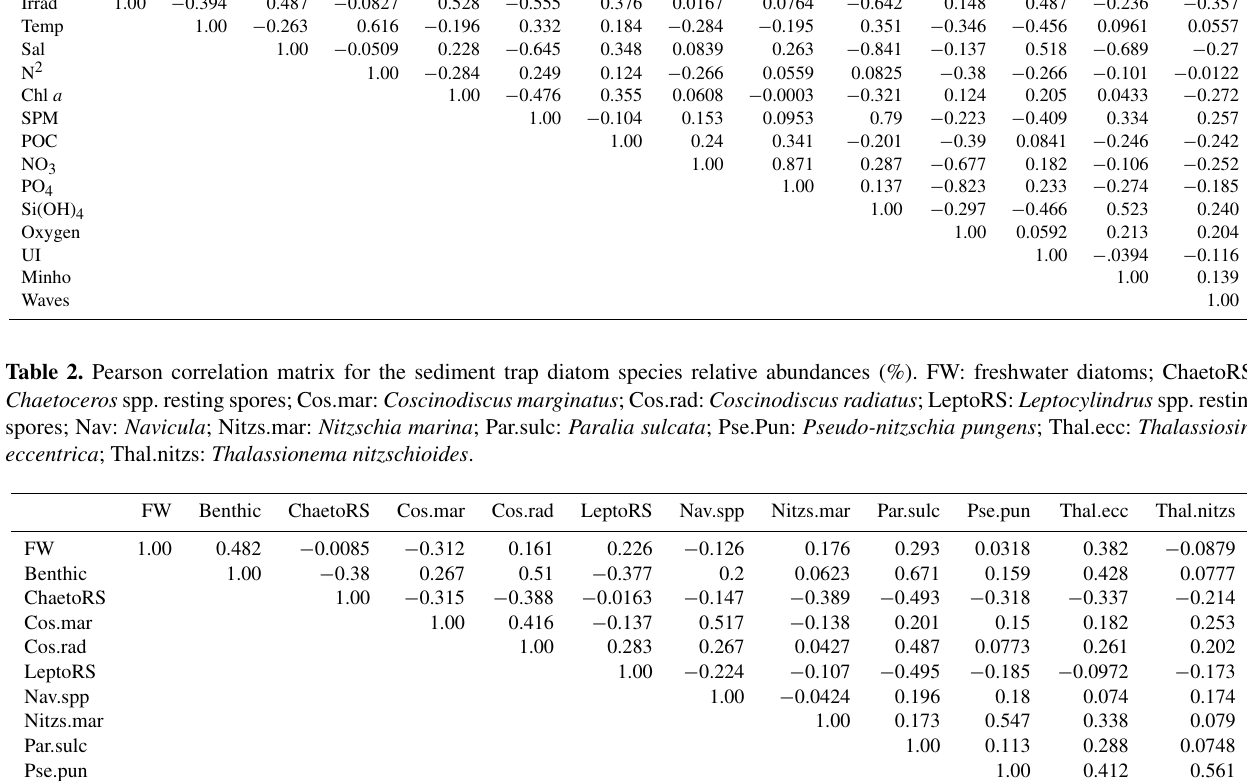
Table 1. Environmental variables matrix Pearson correlations. Irrad: irradiance; Temp: temperature; Sal: salinity; N 2 : Brunt–Väisälä fre- quency parameter; Chl a : chlorophyll a ; SPM: suspended particulate matter; POC: particulate organic carbon; UI: upwelling index; Minho: Minho River discharge; Waves: Significant wave height off A Guarda (WANA G ) station. Irrad